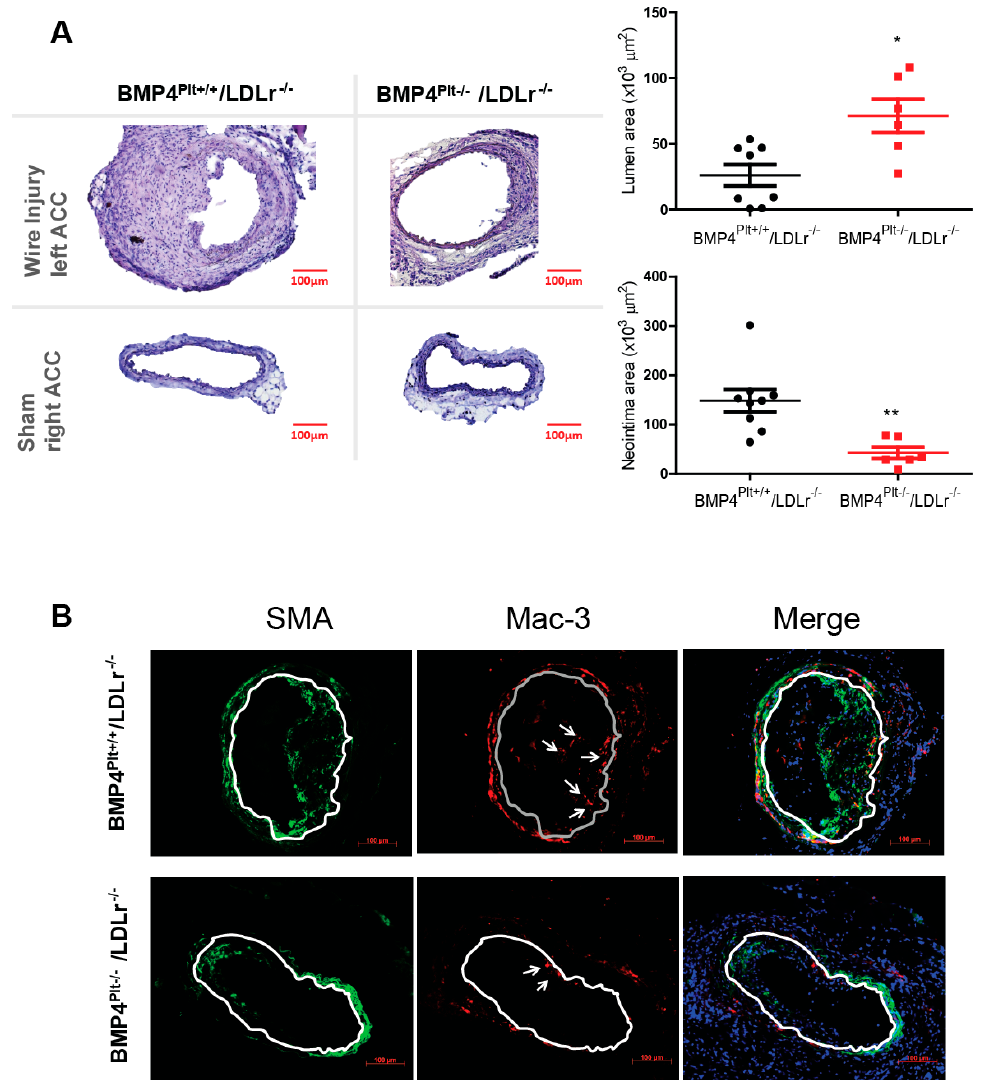
Figure 1. Platelet BMP-4 mediates neointimal formation. ( A ) Representative sections from the carotid arteries after wire injury or sham in BMP4 Plt − / − /LDLr − / − mice and control littermates. n = 8 for BMP4 P+/+ /LDLr − / − mice, and n = 6 for BMP4 Plt − / − /LDLr − / − mice ( B ) Representative images of the carotid lesion stained for SMA and Mac-3. n = 3 * p ≤ 0.05; ** p ≤ 0.01.